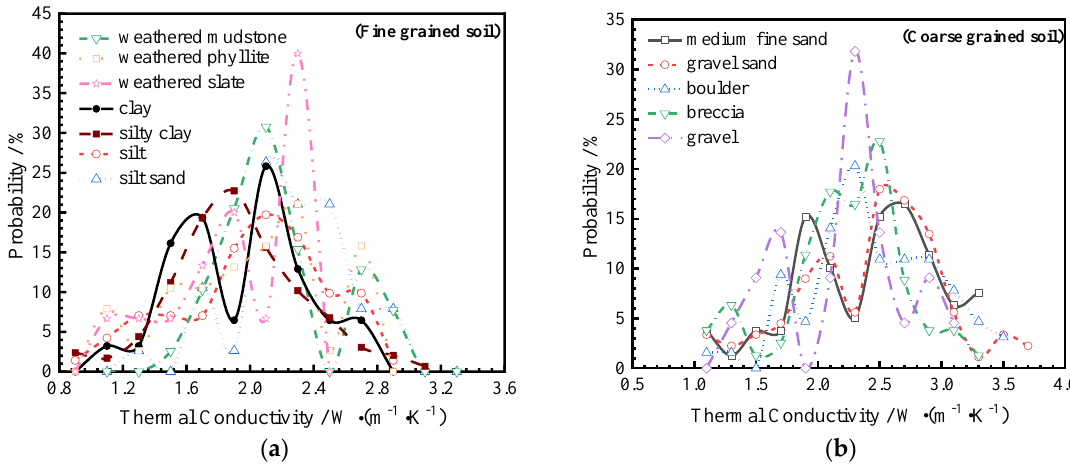
Figure 6. Probability distribution of thermal conductivity of 12 types of frozen soil. ( a ) Fine grained soil, ( b ) Coarse grained soil.